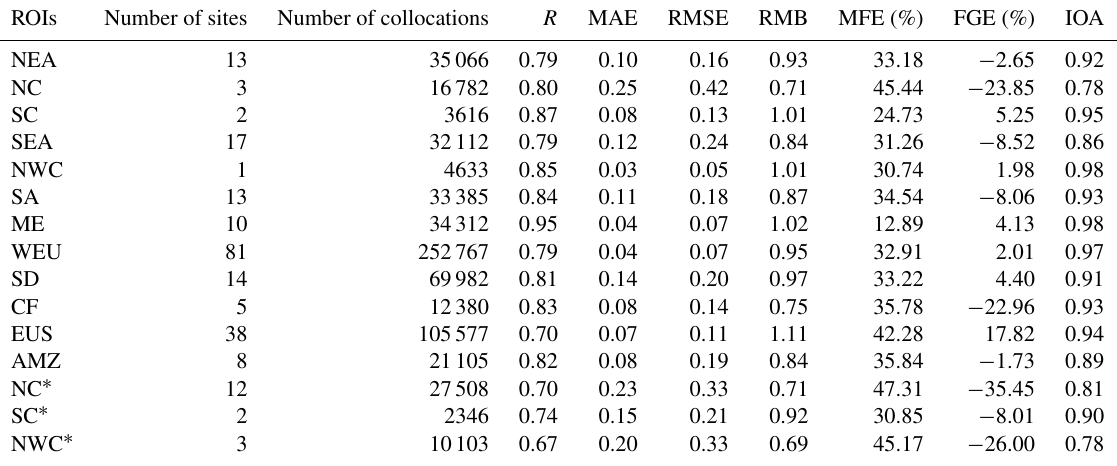
∗ Indicates the statistical results for CARSNET